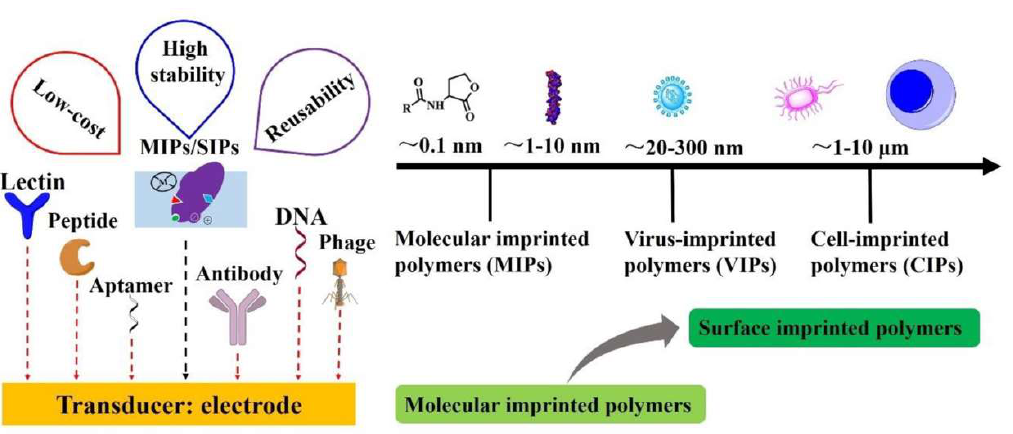
Figure 5. Various receptors for electrochemical biosensors using the Molecularly Imprinted Polymers